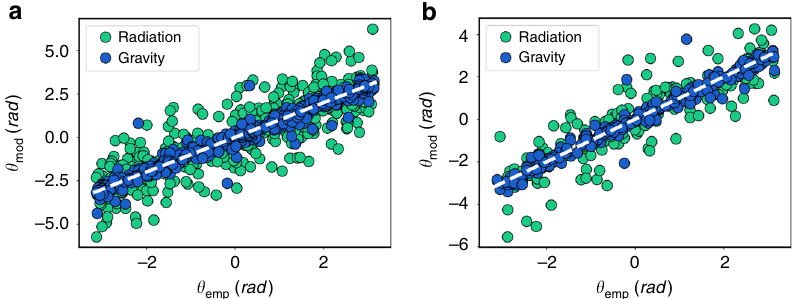
(cid:2) ! i respect to the positive horizontal axis measured from the data Θ i in each cell ð gravity Þ ¼ 0 : 96 and R 2 ð radiation Þ ¼ 0 : 70. For Paris, they are R 2 P P